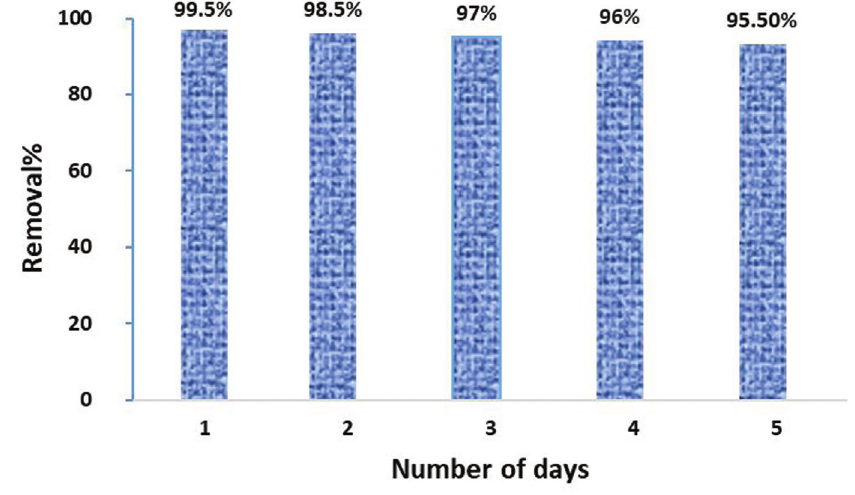
Figure 7: Reusability test of wheat-mediated CuO NPs catalytic efficiency toward 4-nitrophenol pollutant